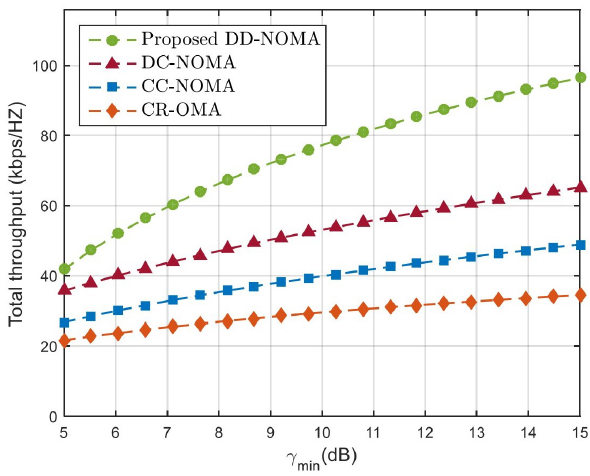
Figure 7. Total user throughput under different SINRs.